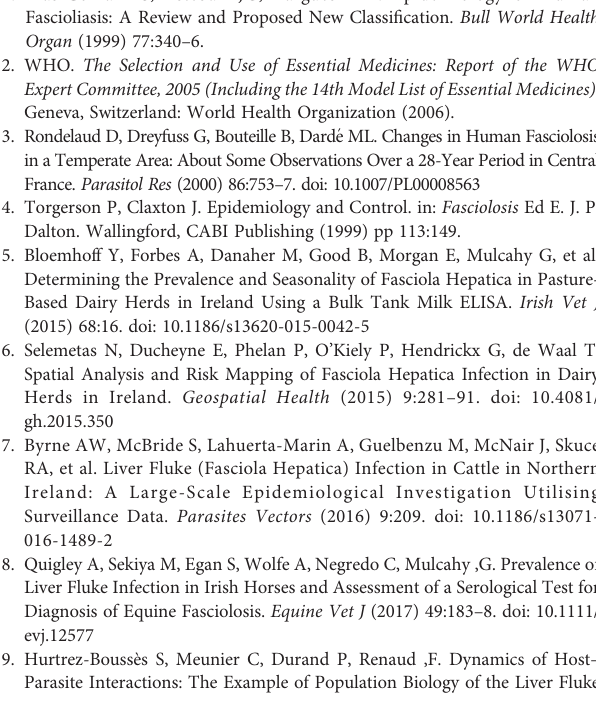
Supplementary Figure 2 | Role of PKR in interferon induction and antiviral response pathway and the genes expressed in PBMC involved in the pathway at Supplementary Table S1 | Sample metadata and parameters of sequencing and alignment quality.